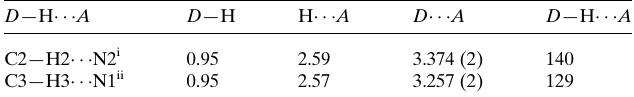
Table 1 Hydrogen-bond geometry (A˚ , (cid:3) ).